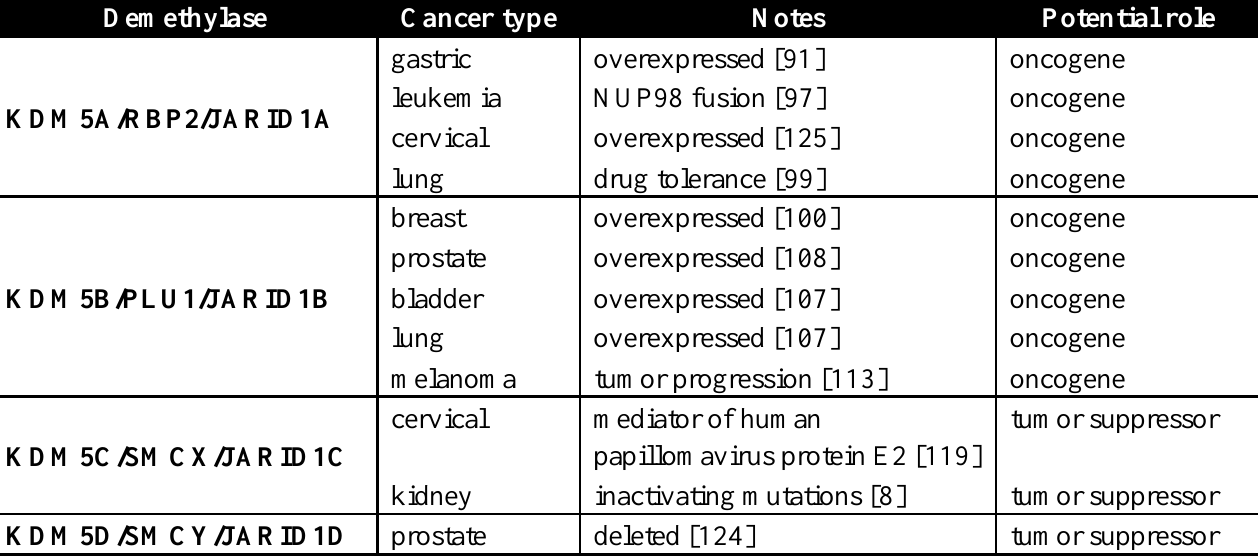
Table 1. KDM5 family demethylases in